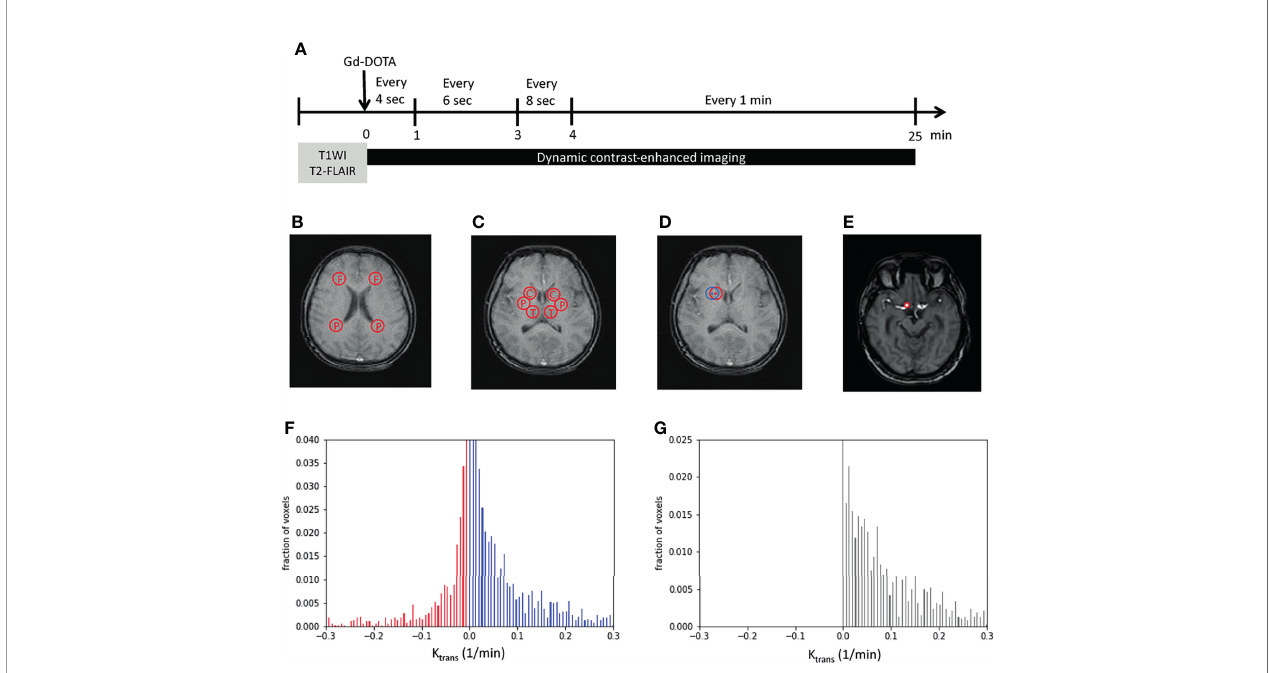
FIGURE 1 | Image processing. (A) Imaging protocols included structural images (T1WI and T2-FLAIR images) and dynamic imaging. The time bar shows dynamic imaging intervals during the 25-min acquisition time. (B, C) Examples show the two regions of interest (ROIs) in the white matter (WM) (B) , namely, the frontal and parietal WM, and three ROIs in the gray matter (C) , namely, the caudate head, putamen, and thalamus. (D) An example shows the perturbation of ROIs. The center and radius of the initial ROI (in red) randomly oscillated within three pixels to obtain another ROI (in blue) that was near to the initially examined ROI (in red). (E) The internal carotid artery was selected and set as the region of plasma in Patlak analysis. (F, G) The K trans of each pixel was plotted as a histogram. Red bars indicated negative K trans values and were considered as noise (F) . The noise was supposed to exist with the same distribution on the positive side. By subtracting noise (red bars) from the original histogram (blue bars), tissue permeability was observed (black bars in G ). x -axis, K trans ; y -axis, the fraction of voxels. F, frontal; P, parietal; C, caudate head; P, putamen; T, thalamus; Gd-DOTA, gadoterate meglumine; T1WI, T1-weighted image; T2-FLAIR, T2-weighted fl uid-attenuated inversion